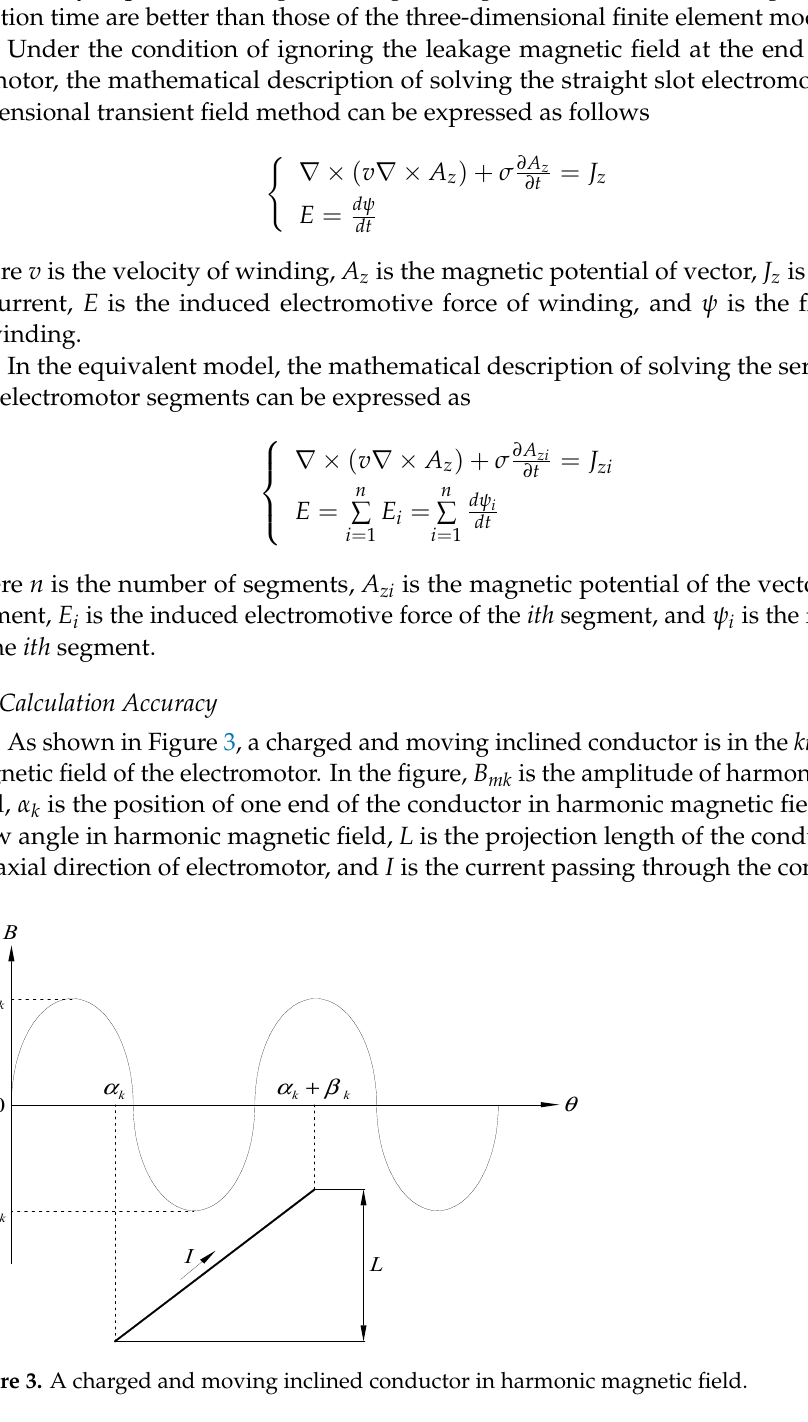
Figure 3. A charged and moving inclined conductor in harmonic magnetic field.